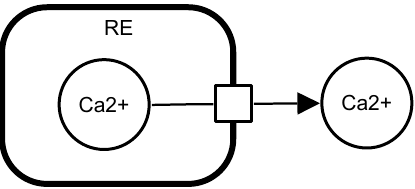
Figure 2.25: Translocation of calcium ion out of the endoplasmic reticulum. Note that the process does not have to be located on the boundary of the compartment . A process is not attached to any compartment .